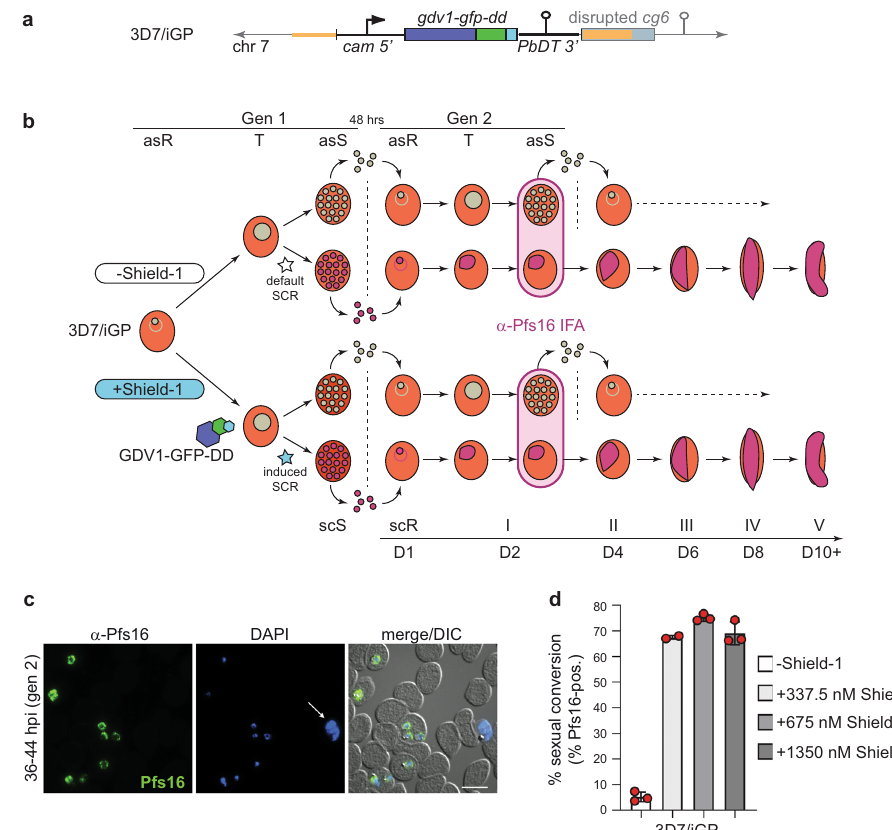
Fig. 1 Description of the inducible gametocyte producer line 3D7/iGP. a Schematic of the disrupted cg6 locus carrying a single inducible GDV1-GFP-DD expression cassette. The 5 ′ and 3 ′ homology regions used for CRISPR/Cas9-based transgene insertion are shown in orange. b Schematic of the in vitro culture protocol used to quantify sexual commitment rates (SCRs). Synchronous 3D7/iGP ring stage parasites are split at 0 – 16 hpi and Shield-1 is added to one half of the population to trigger GDV1-GFP-DD expression. SCRs are quanti fi ed by determining the proportion of early stage I gametocytes in the total iRBC progeny 36 – 44 hpi (day 2 of gametocytogenesis) by α -Pfs16 IFAs combined with DAPI staining. Asexual parasites are depicted in grey, sexually committed parasites and gametocytes are depicted in purple. asS/scS, asexual/sexually committed schizont; asR/scR, asexual/sexually committed ring stage; T, trophozoite; I – V, gametocyte stages I – V; D1 – D10, days 1 – 10 of gametocyte maturation. Gen 1/2, generation 1/2. c α -Pfs16 IFA images illustrating the high proportion of early gametocytes in the progeny of Shield-1-treated 3D7/iGP parasites. The white arrow highlights a Pfs16-negative schizont. Nuclei were stained with DAPI. DIC, differential interference contrast. Images are representative of three independent experiments. Scale bar, 10 µ m. d Proportion of Pfs16-positive iRBCs (SCRs) in the progeny of 3D7/iGP treated with three different Shield-1 concentrations and the untreated control ( − Shield-1) (mean ± SD, n = three biologically independent experiments; two experiments for parasites treated with 337.5 nM Shield-1). Closed circles represent data points for individual experiments (>156 DAPI-positive cells counted per